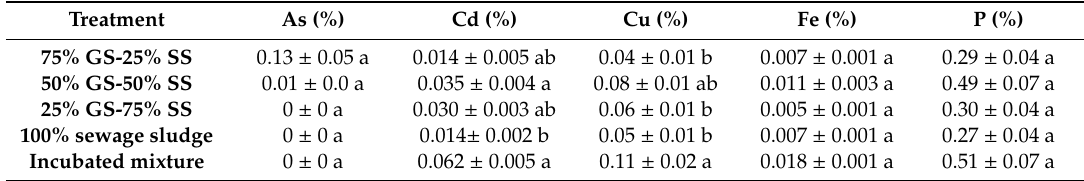
Table 8. Percentage of translocation of elements to the aerial part (%) (averaged value ± standard error; n = 3 or